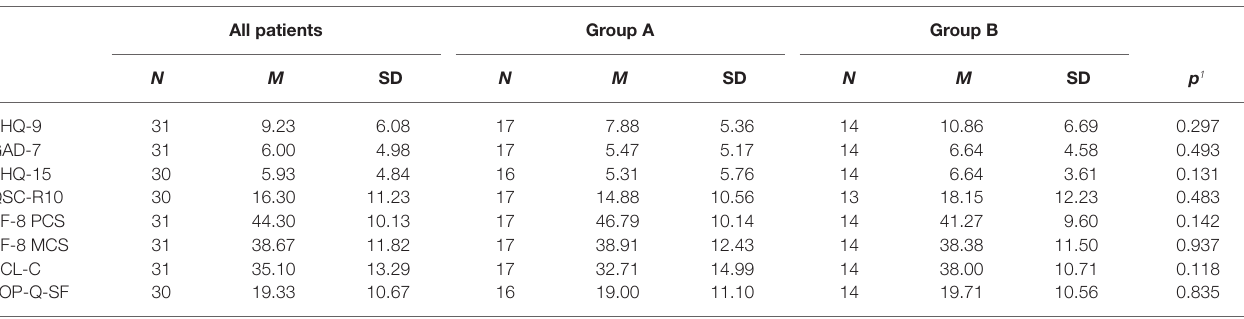
TABLE 3 | Distress and symptom burden.